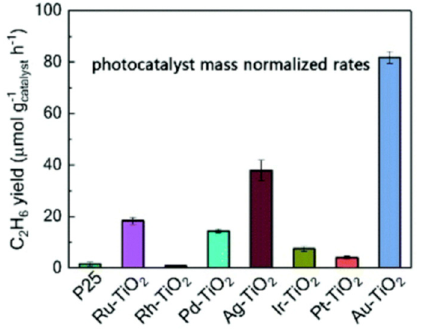
Figure 6. Ethane yield by non-oxidative methane coupling using various metal-loaded TiO 2 catalysts. Reproduced from [28] with permission from The Royal Society of Chemistry.